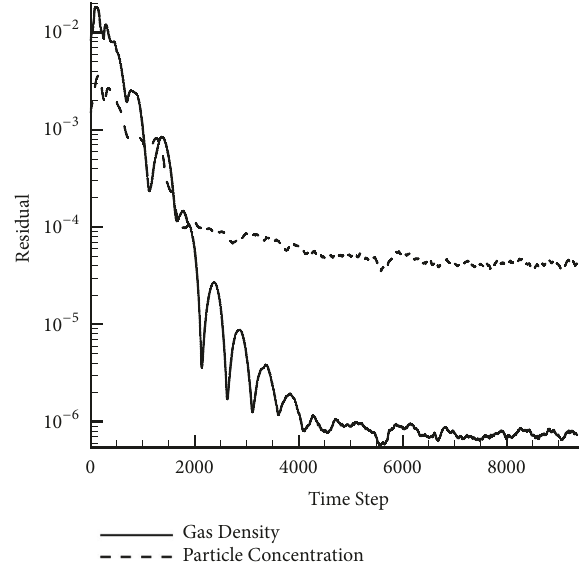
Figure 3: Convergence history in two-phase flow.